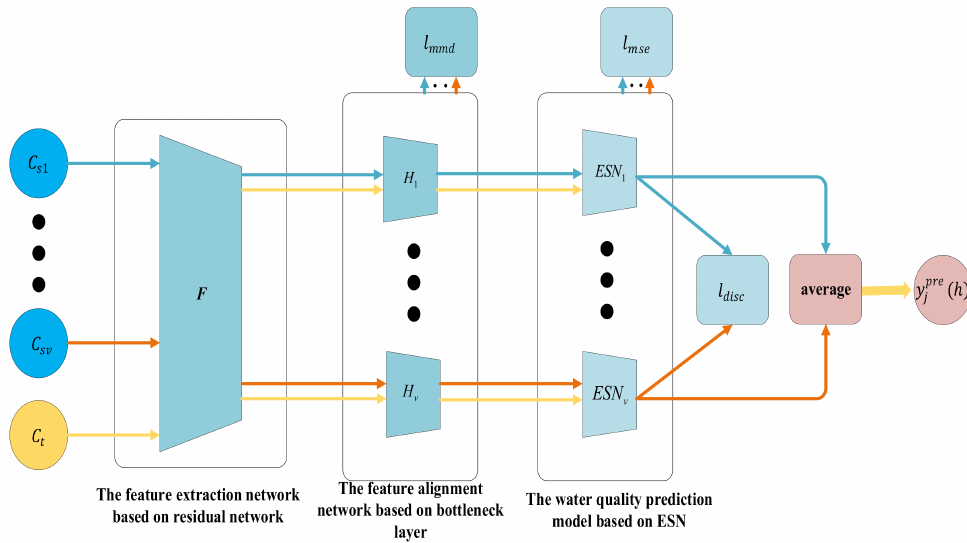
Figure 1. Water quality prediction framework based on MSTL.